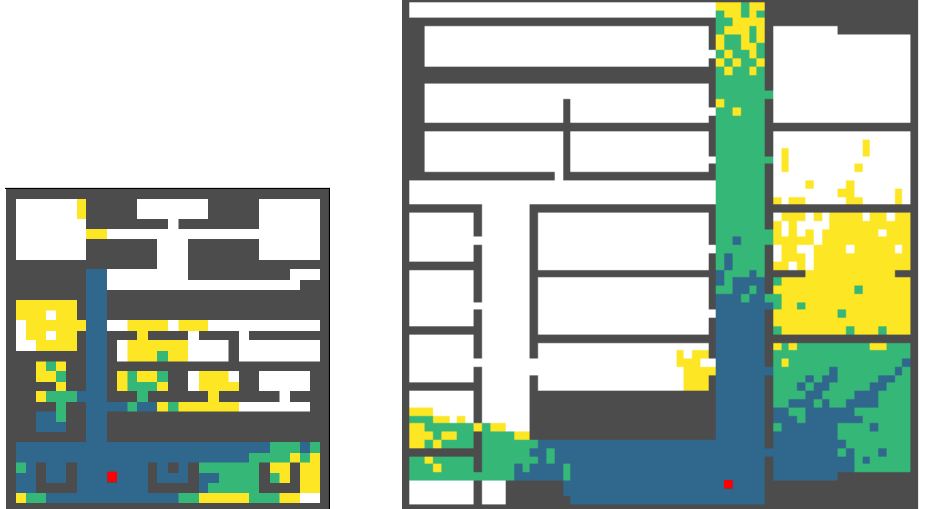
Figure 4. Example of communication range reduction in the facility ( left ) and the lab ( right ) envi- ronments. With respect to the position marked in red, the plot highlights areas within communication range (with probability 99%) for S = − 80 (blue), for S = − 100 (green), and for S = − 120